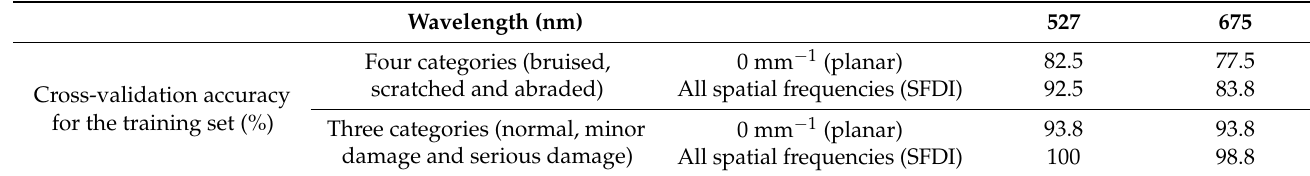
Table 3. The five-fold cross-validation outcomes for two